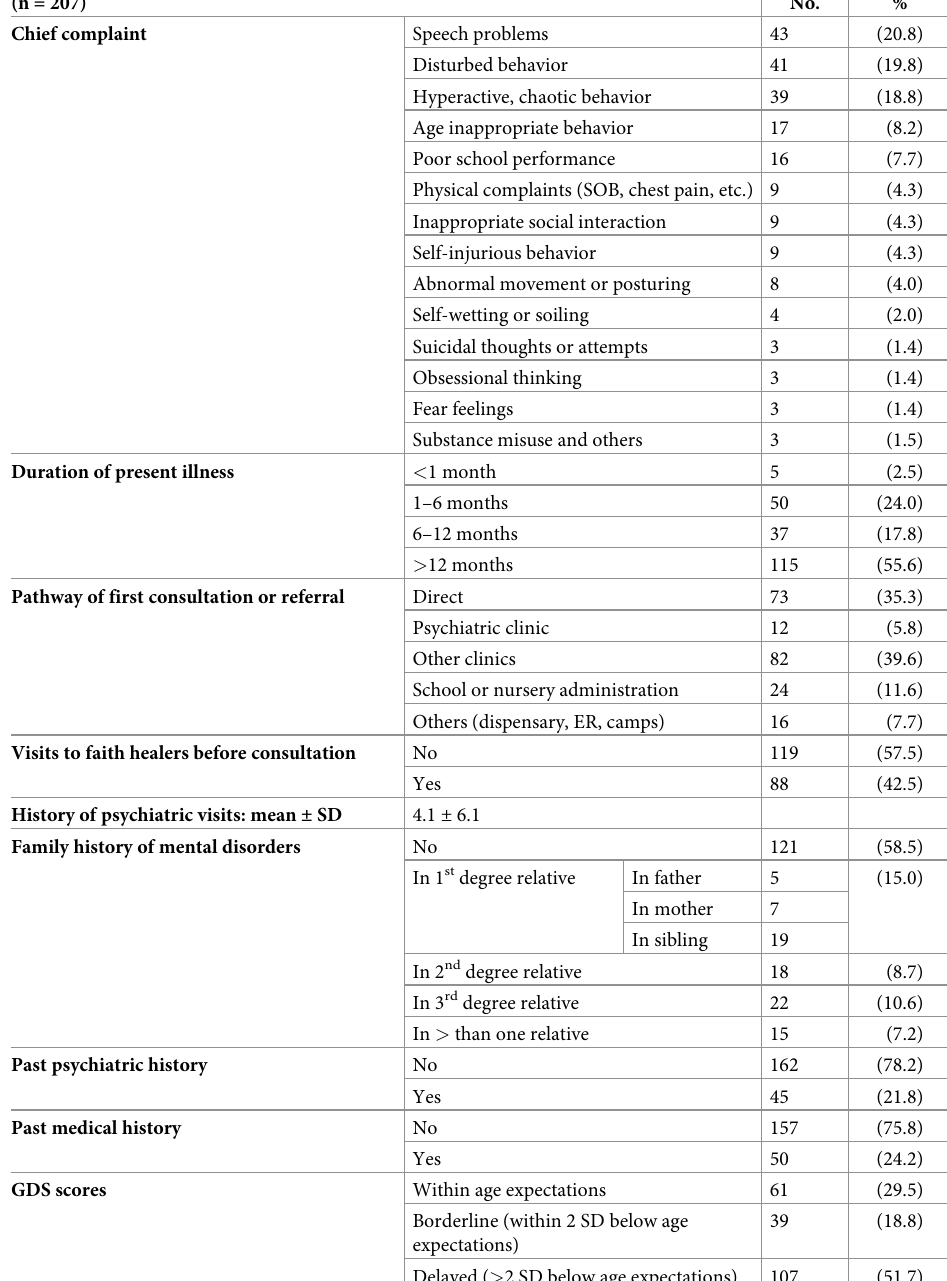
Table 4. Medical and psychiatric history of the